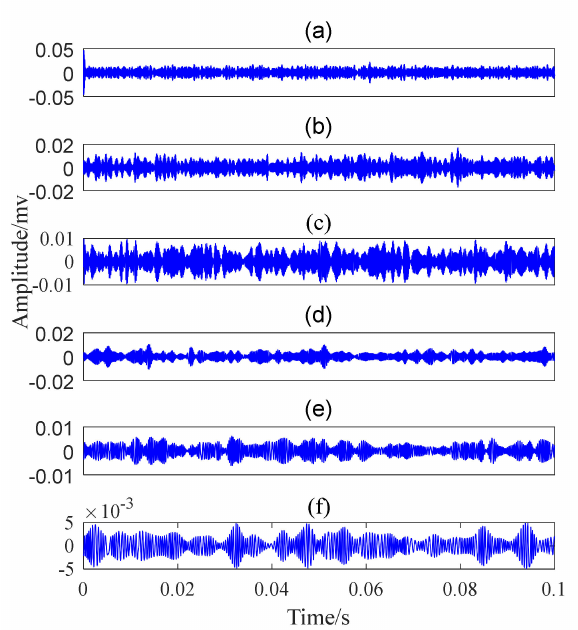
Figure 4. The IMFs of the simulation signal obtained by the EMD method: ( a ) IMF1; ( b ) IMF2; ( c ) IMF3; ( d ) IMF4; ( e ) IMF5; ( f )